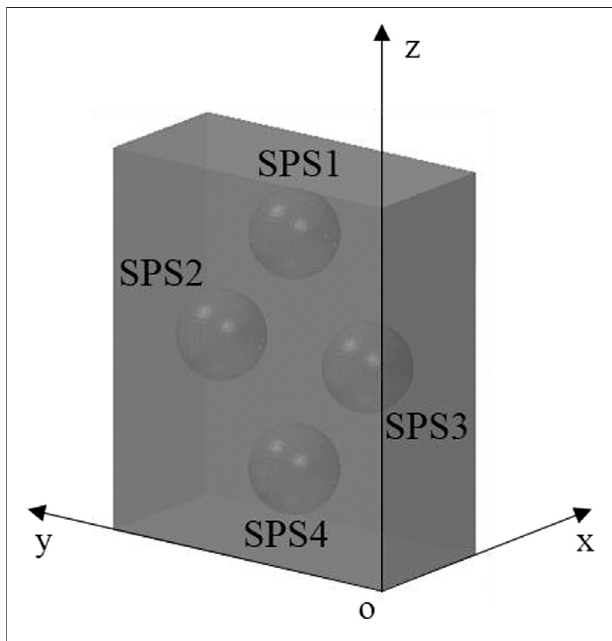
FIGURE 7 | CIM numerical